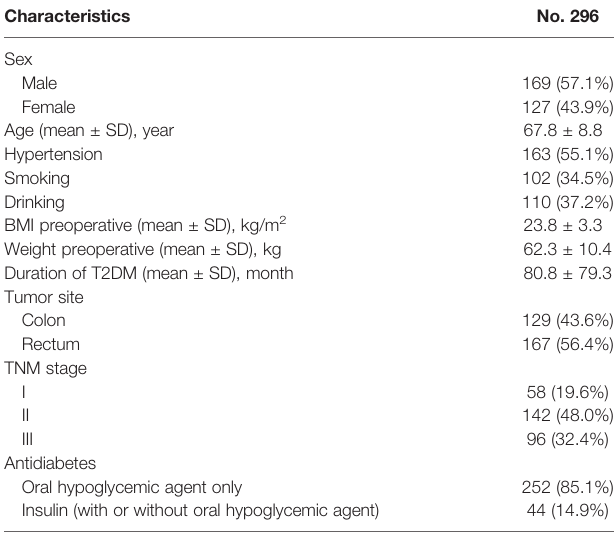
TABLE 1 | Baseline characteristics of patients with concurrent CRC and